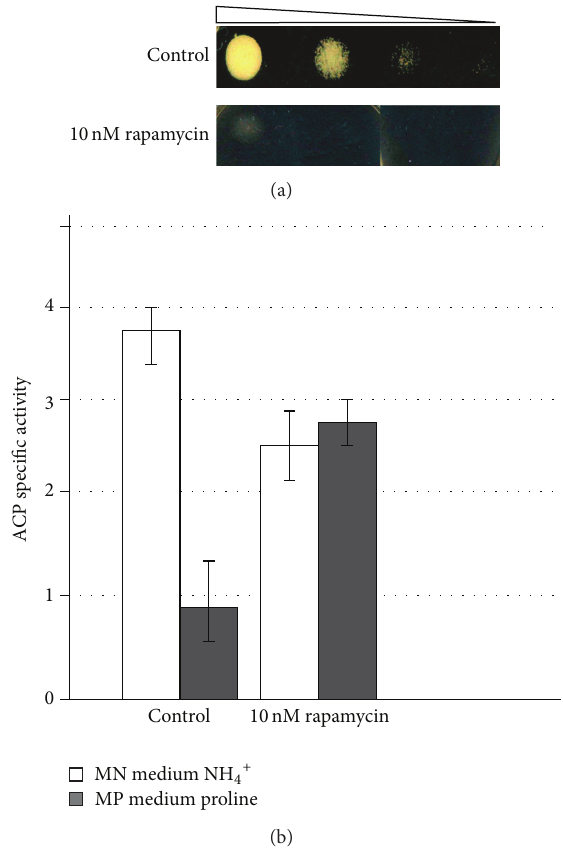
Figure 5: (a) Growth of P. pastoris GS115 strain on YPD medium (control) and on medium containing 10nM rapamycin. (b) Effect of rapamycin treatment on ACP specific activity of P. pastoris tr2- 1-GS115 strain grown in media with different nitrogen sources (MN with ammonium sulphate and MP with proline).